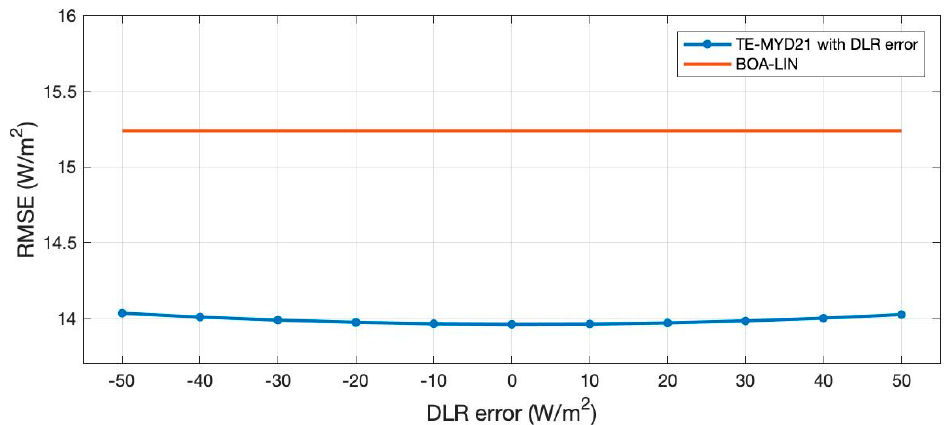
Figure 9. The accuracy comparison of BOA-LIN and TE-MYD21 method with DLR errors.